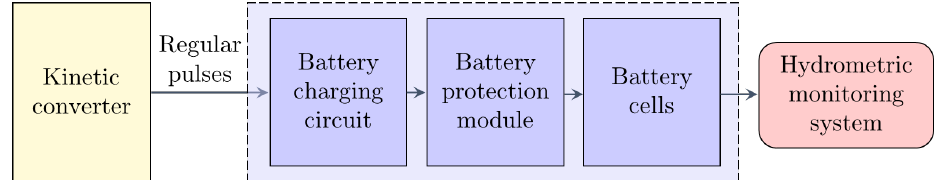
Figure 6. Block diagram of the autonomous hydrometric monitoring system.